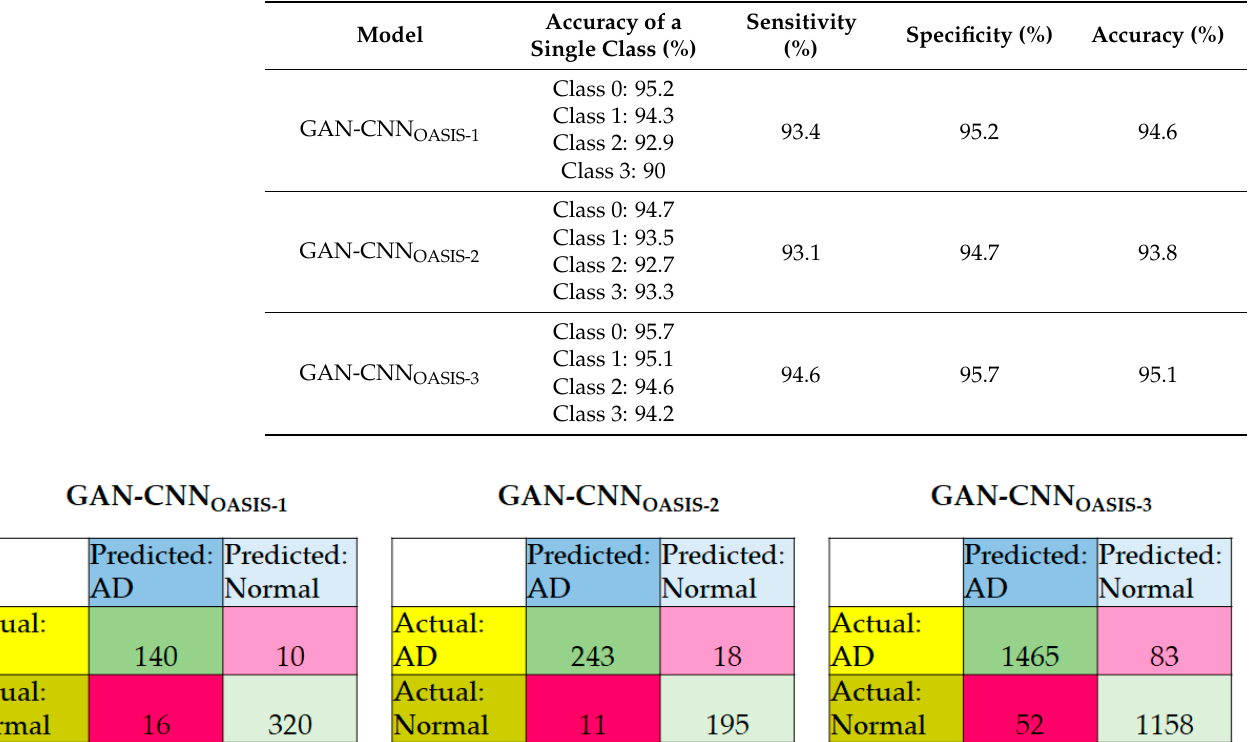
Table 4. Performance evaluation of the GAN-CNN for OASIS-1, OASIS-2, and OASIS-3.